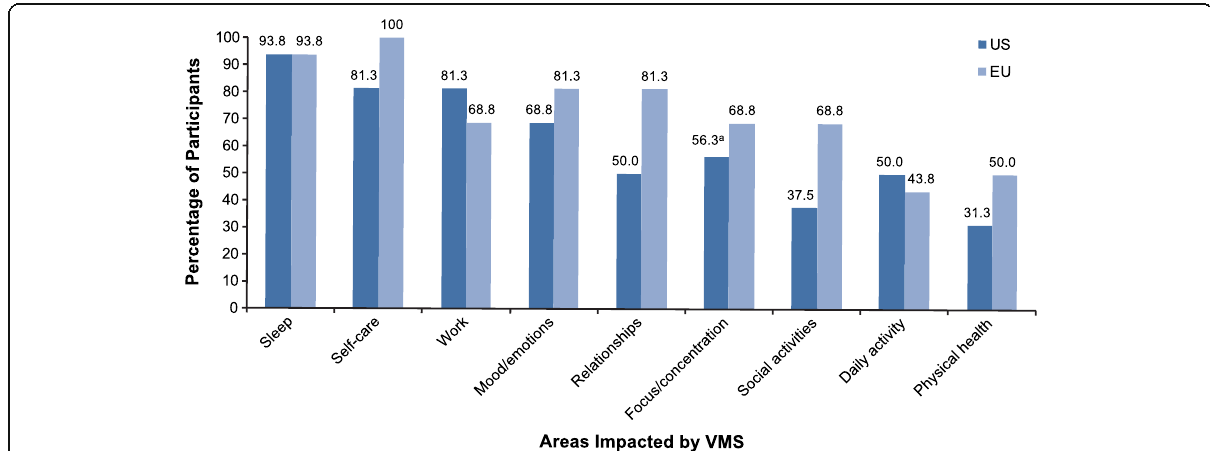
Fig. 1 Areas of life impacted by VMS associated with menopause. During the concept elicitation phase, women were asked general, open-ended questions about the way VMS impacted their lives, and then asked how VMS impacted each of the specific areas shown here. Responses are categorized here to show the percentage of participants who indicated that each area is impacted by their VMS. The EU sample included participants in Paris, France, and Manchester, UK; the US sample included participants in Dallas, TX, and Chicago, IL. a Includes 5 women who reported difficulty concentrating during hot flashes and 4 who reported that lack of sleep due to VMS made them less alert or focused